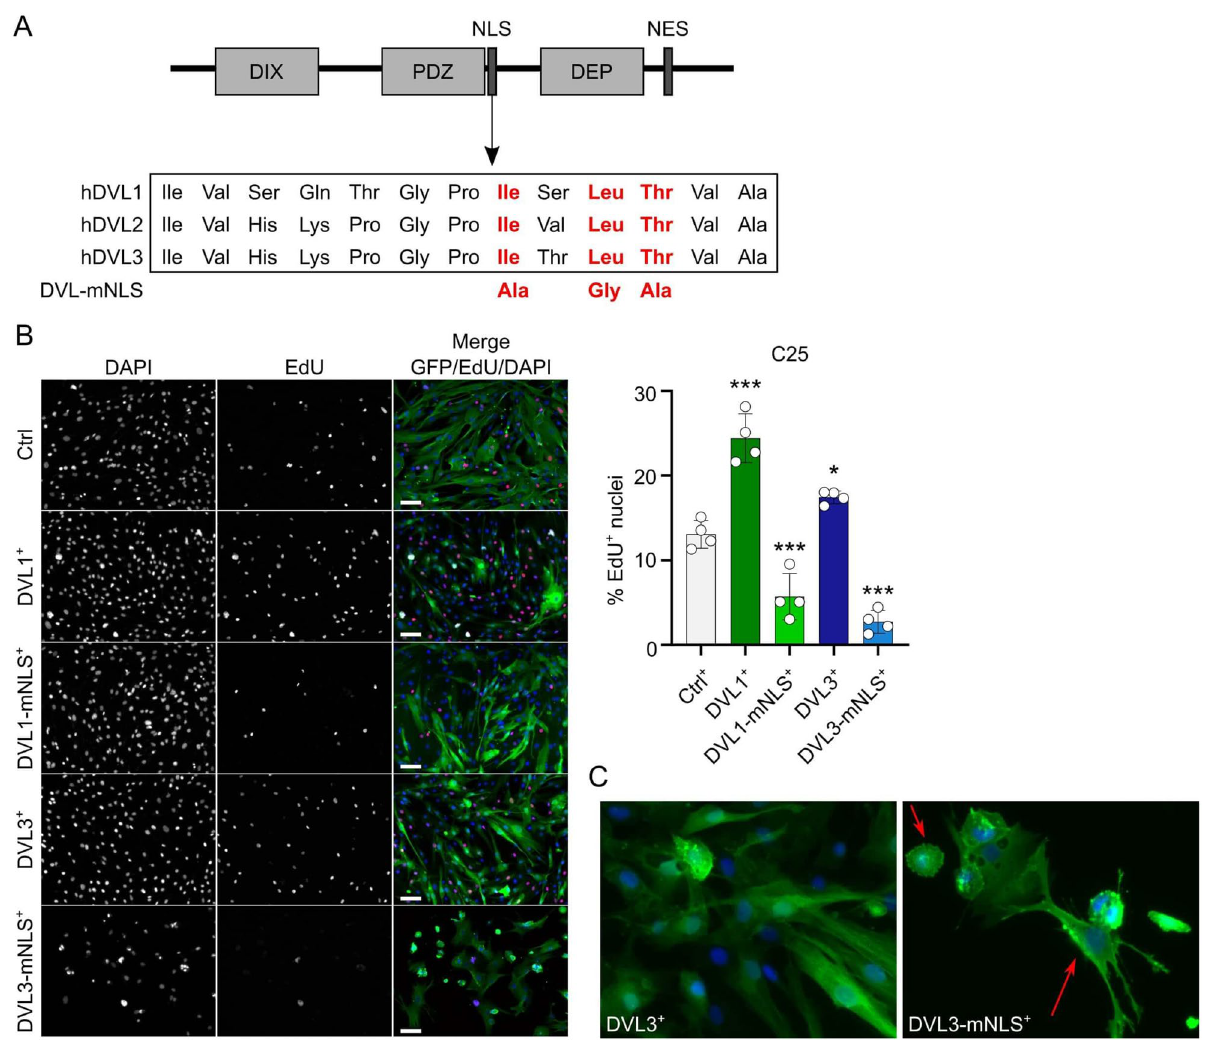
Figure 6. Mutation of the NLS sequence in DVL1 or DVL3 leads to reduced proliferation. ( A ) Schematic of the three conserved domains (DIX, PDZ, DEP) in DVL proteins, together with the positions of the nuclear localisation sequence (NLS) and the nuclear export sequence (NES), together with the changes to key amino acid residues to destroy the NLS (red text). ( B ) Representative images of proliferating C25 DVL1 + , DVL1- mNLS + , DVL3 + , DVL3-mNLS + and control (Ctrl) myoblasts, with incorporated EdU (red), immunolabelled for GFP (green) from the lentivirus (correlated with DVL expression) and DAPI nuclei counterstain (blue). EdU pulse was performed 24 h after seeding stably overexpressing C25 myoblast lines. Scale bar represents 100 µm. Quantification was performed for 4 biological replicates, and significant difference was calculated using a One- way ANOVA with Dunnett’s post hoc test, comparing each group with the control, where an asterisk denotes p < 0.05 and 3 asterisks denotes p < 0.001. ( C ) Representative images of DVL3 + (left) or DVL3-mNLS + (right) C25 myoblasts. Red arrows point to an unusually round, and an uncharacteristically elongated, DVL3-mNLS +